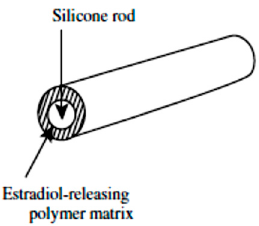
Figure 18. Compudose implant.